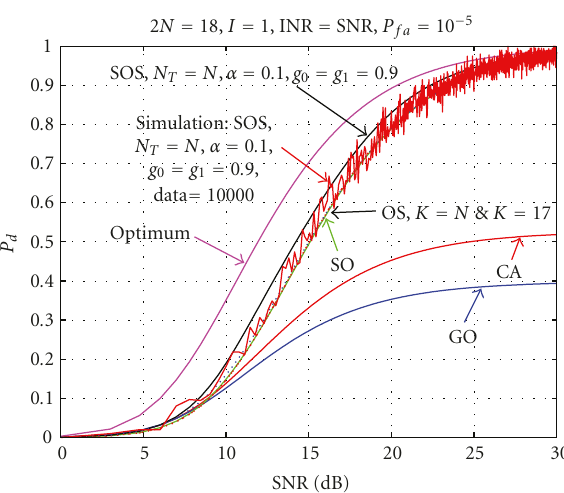
Figure 12: Comparison of P d of SOS I with N T = N , α = 0 . 1, β 0 = β 1 = 9, and g 0 = g 1 = 0 . 9 in multiple targets environment for 2 N = 18 and P fa = 10 − 6